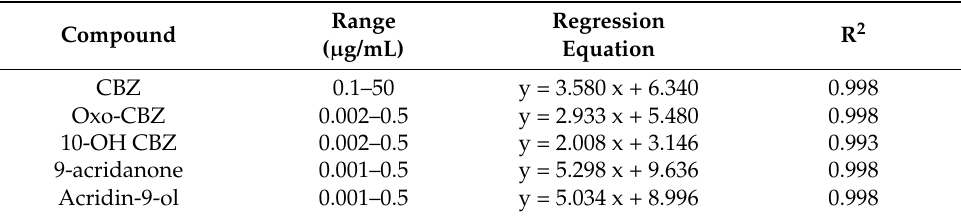
Table 4. Linearity values of CBZ and the detected degradation intermediates in water.